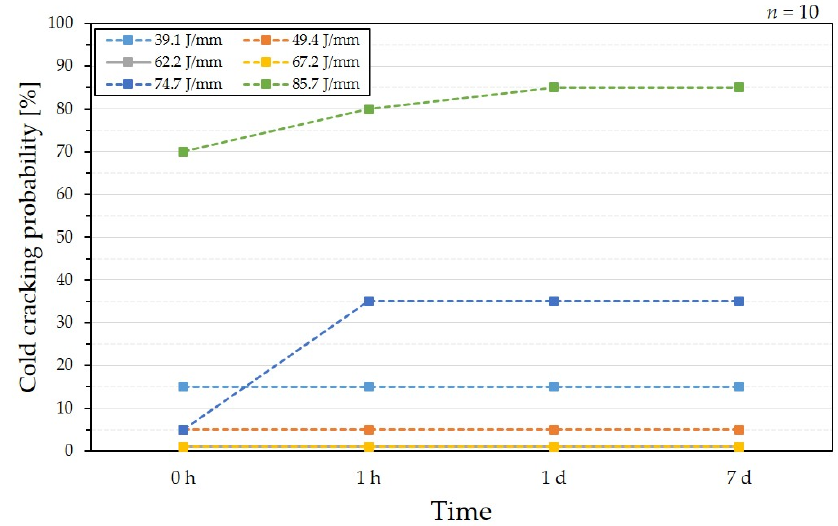
Figure 11. Cold crack formation of steel A depending on line energy and